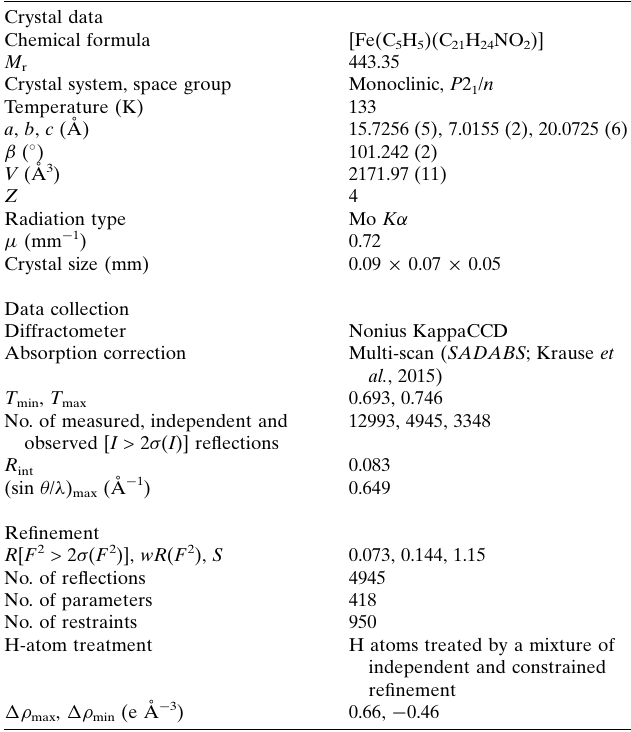
Crystal data Chemical